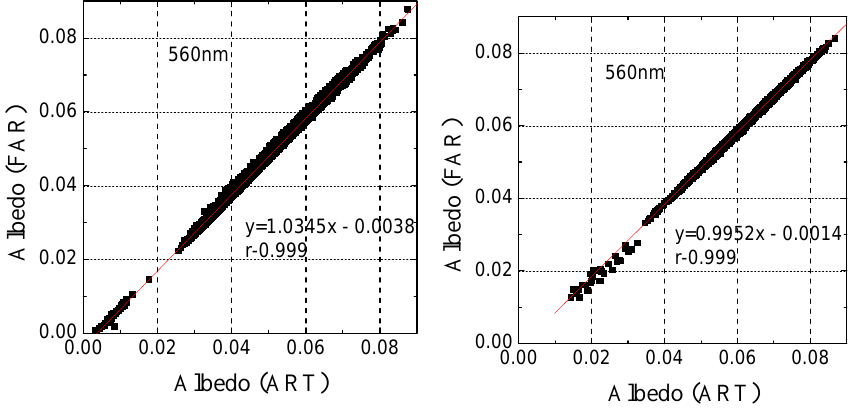
Fig. 18. Correlation between the ART and FAR retrieved albedo of land at 560nm for clear (left) and turbid (right) atmospheres (see Fig. 10).